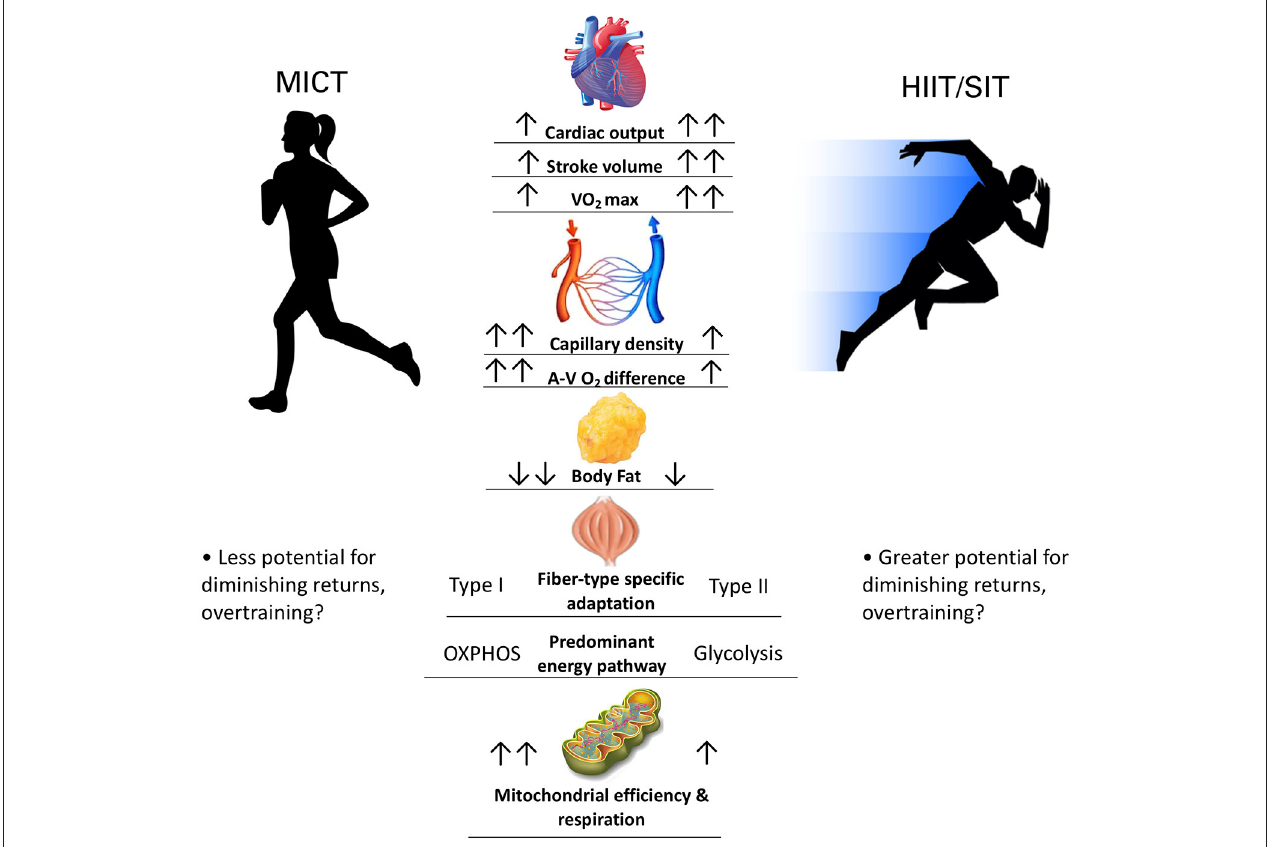
FIGURE 1 | Comparing physiological adaptations between MICT and HIIT/SIT. Two arrows denotes greater magnitude of